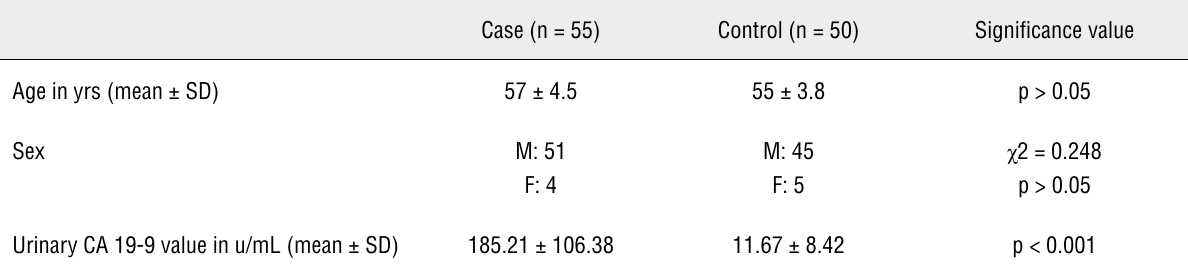
Table 2 - Comparative data analysis of age, sex and urinary CA 19-9 between case and control